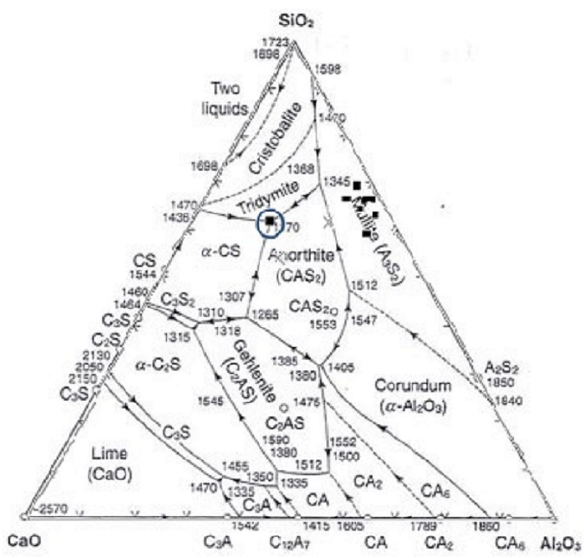
Figure 8. Ternary composition diagram of CaO-SiO 2 -Al 2 O 3 showing SG4 fractions (crosses) with compositions closer to the eutectic (circled square) (remaining fractions: squares).